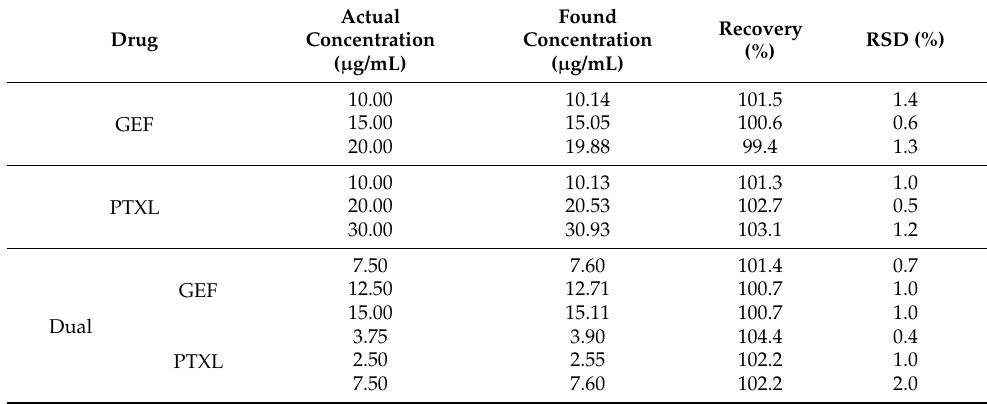
Table A4. Recovery values of GEF, PTXL, dual-GEF, and dual-PTXL. Drug